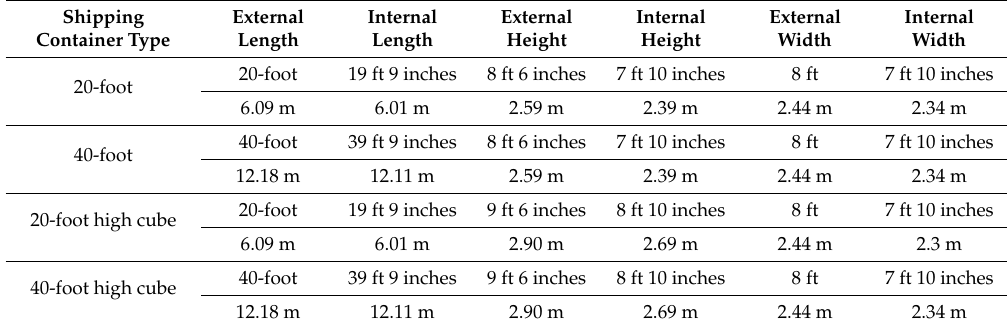
Table A1. Some standard shipping container dimensions.